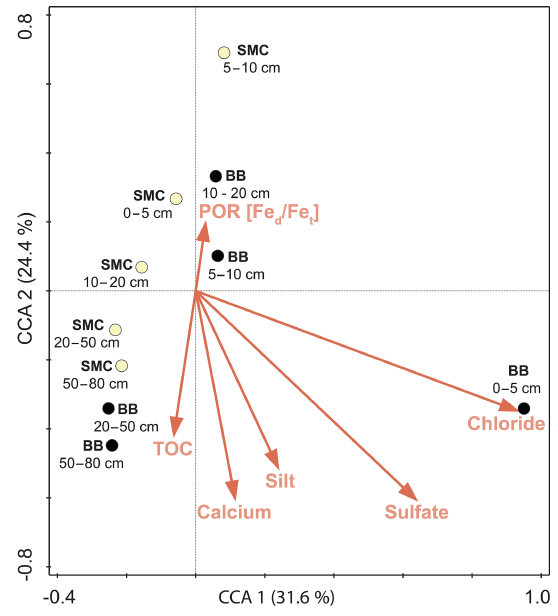
Figure 6. Canonical correlation analysis of the microbial compo- sition of soil profiles from Brandy Bay (BB; black symbol) and Santa Martha Cove (SMC; yellow symbol) based on Bray–Curtis dissimilarities of the OTU data and its associated environmental parameters. If the Bonferroni-corrected p value was below 0.05, a given environmental parameter was included in the visualization. The amounts of chloride, sulfate, silt, Ca and TOC contents, and the Fe d / Fe t ratio explained 49.9% of the microbial community compo-